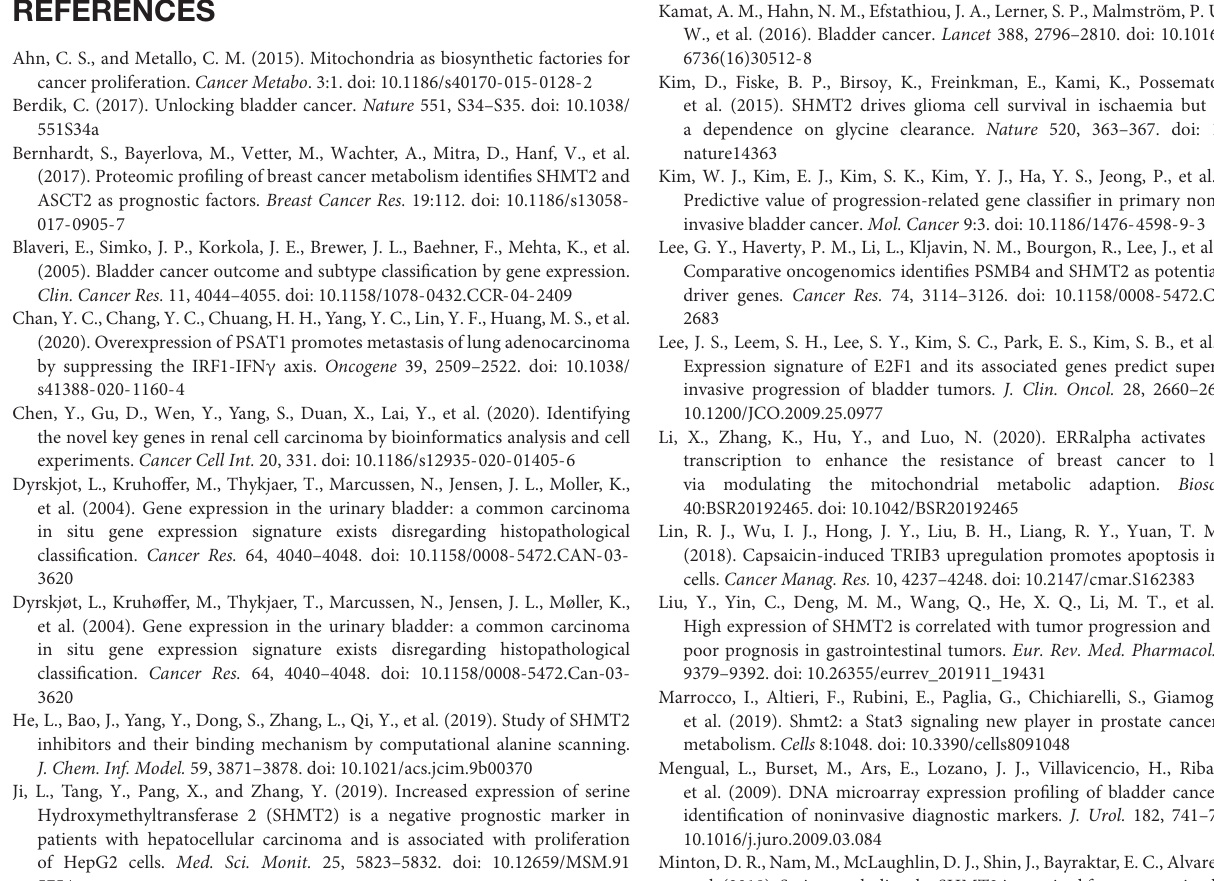
Supplementary Table 1 | Baseline data of bladder cancer patients of TCGA.